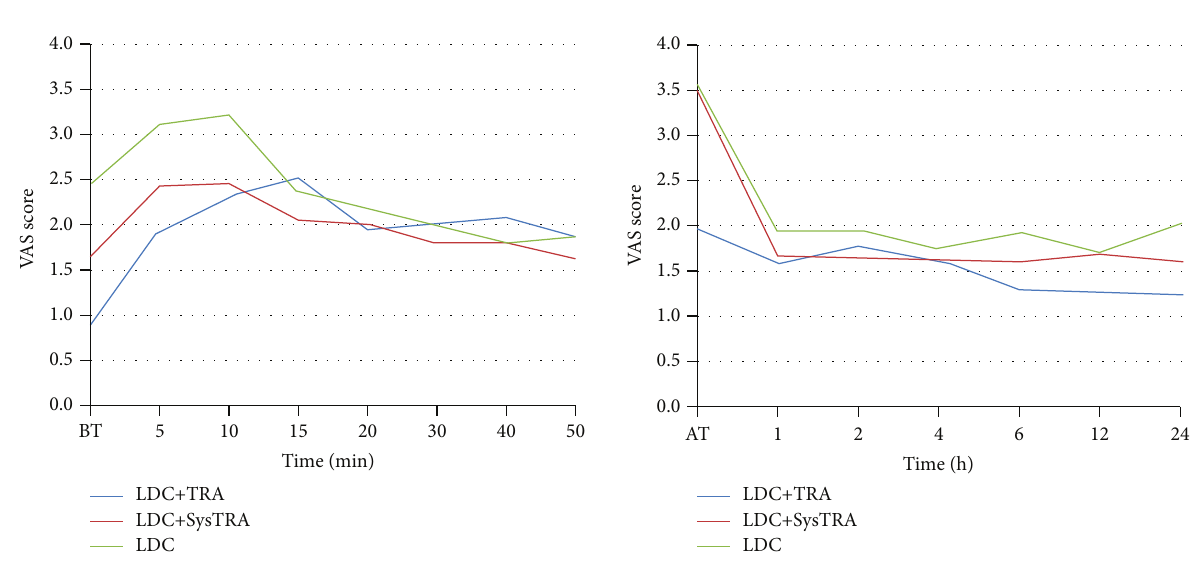
Figure 1: Change in visual analogue scale (VAS) scores in time. BT, before tourniquet; AT, after